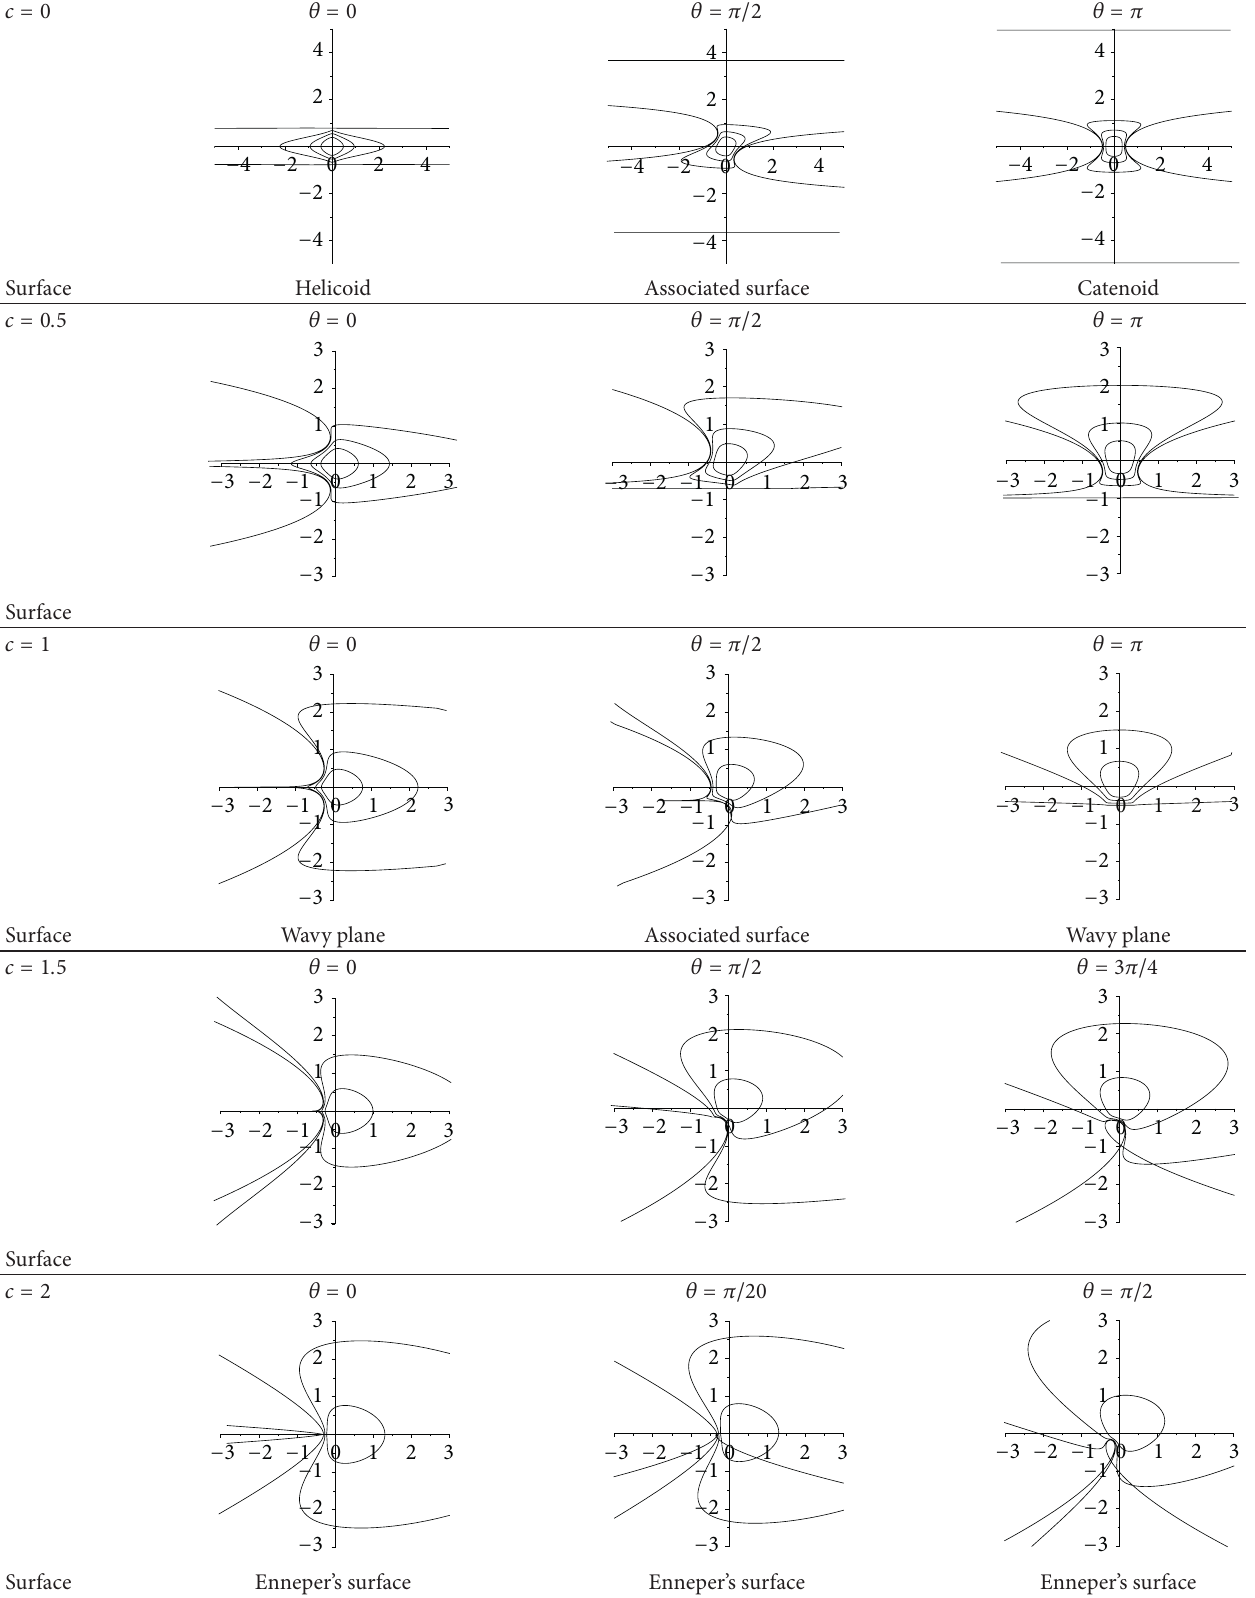
Table 1: Images of 𝑓 𝑐,𝜃 (|𝑧| = 𝑟) , 𝑟 = 0.4, 0.6, 0.8, 0.9999 , and the corresponding minimal surfaces. 𝑐 =